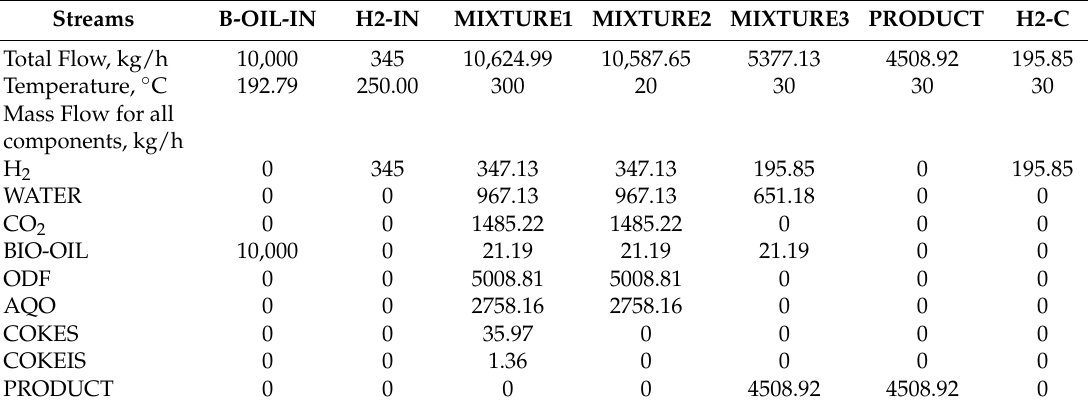
Table A3. Simulated results for main streams of products from mild hydrogenation of bio-oil at 300 ◦ C and 0 MPa and deep hydrogenation at 400 ◦ C and 15 MPa.